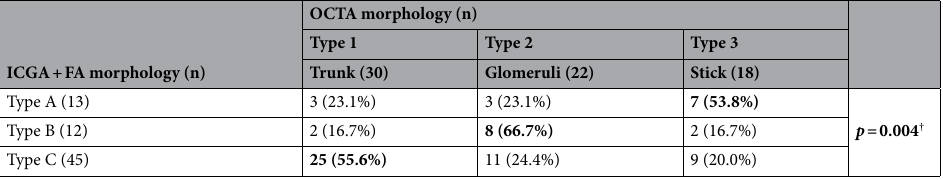
Table 2. Correlation of BVN morphology detected using OCTA and ICGA + FA in PCV patients. Abbreviations: OCTA optical coherence tomography angiography, ICGA indocyanine green angiography, FA fluorescent angiography, PCV polypoidal choroidal vasculopathy. † Chi-square test. Values in bold indicate p < 0.05 and were considered statistically